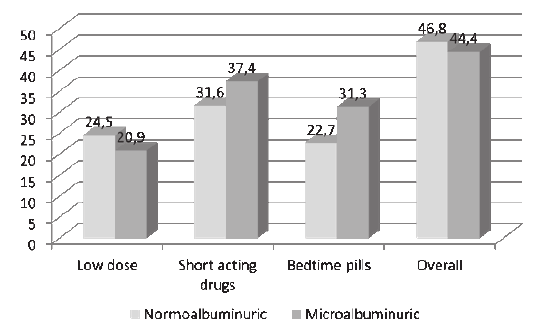
Figure 3. Possible therapeutic mistakes. Differences between groups are not significant.